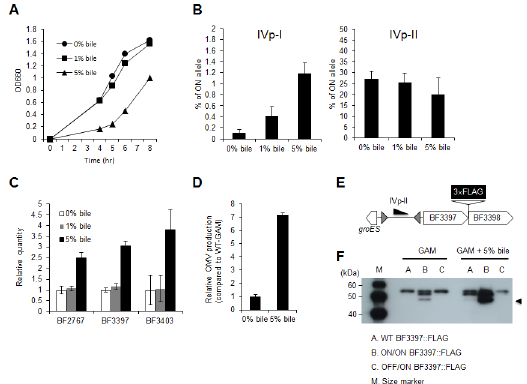
Fig 7. Effect of bile exposure on B . fragilis OMV formation. (A) Growth of B . fragilis YCH46 in GAM supplemented with the indicated bile concentrations. (B) qPCR was used to determine the relative abundance of the IVp-I-ON or IVp-II-ON genotypes after exposure to the indicated bile concentration. (C) Effect of bile exposure on the expression of an IVp-I-regulated EPS production gene (BF2767) and IVp-II- regulated membrane protein genes (BF3397 and BF3403). (D) OMV production of B . fragilis increased 7-fold after exposure to 5% bile. (E) Schematic of the 3 x FLAG-tag fusion to the C-terminus of the BF3397-encoded protein. (F) Enhancement of the BF3397-encoded membrane protein in response to 5% bile. A B . fragilis YCH46 derivative with a 3 x FLAG-tag sequence fused to BF3397, as shown in panel E, was exposed to 5% bile: the production of BF3397 was assessed by Western blotting with an anti-FLAG antibody. Upper, middle, and lower bands indicate the anti-FLAG tag antibody used for immunoprecipitation, BF3397 (unprocessed form), and N-terminally processed BF3397 (indicated by arrowheads),